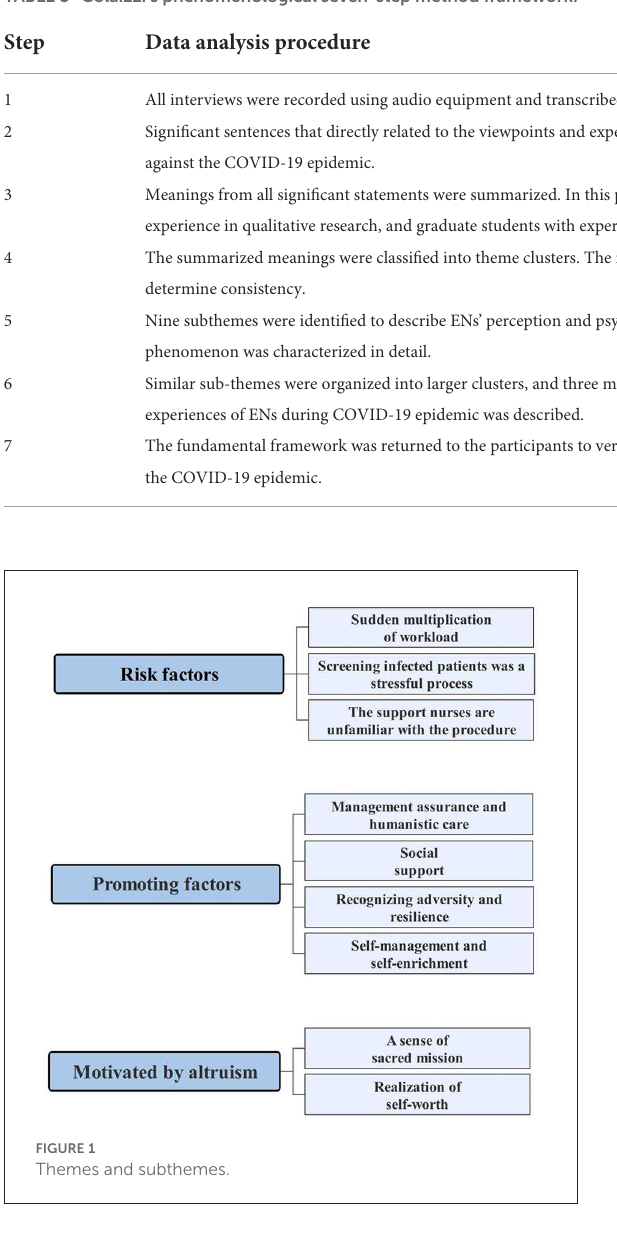
TABLE 3 Colaizzi’s phenomenological seven-step method framework.